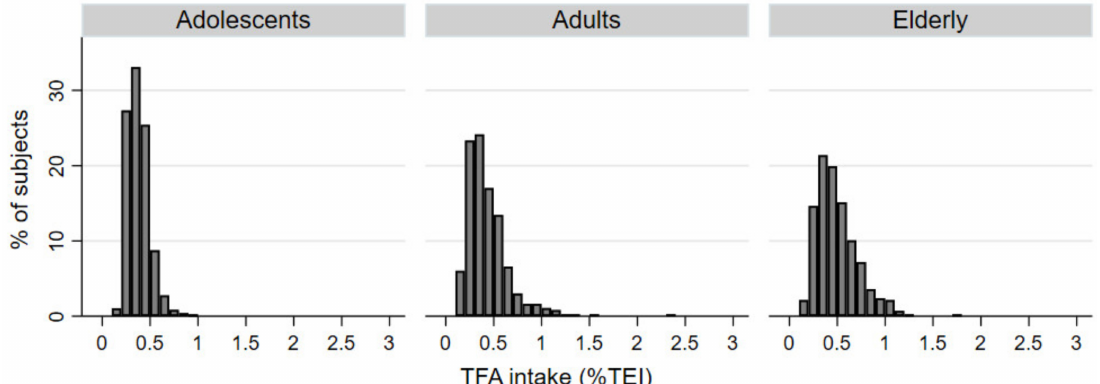
Figure 1. Histograms of daily dietary intake of total trans fatty acids (TFAs) expressed in percentage of total energy intake (%TEI) in adolescents, adults, and elderly